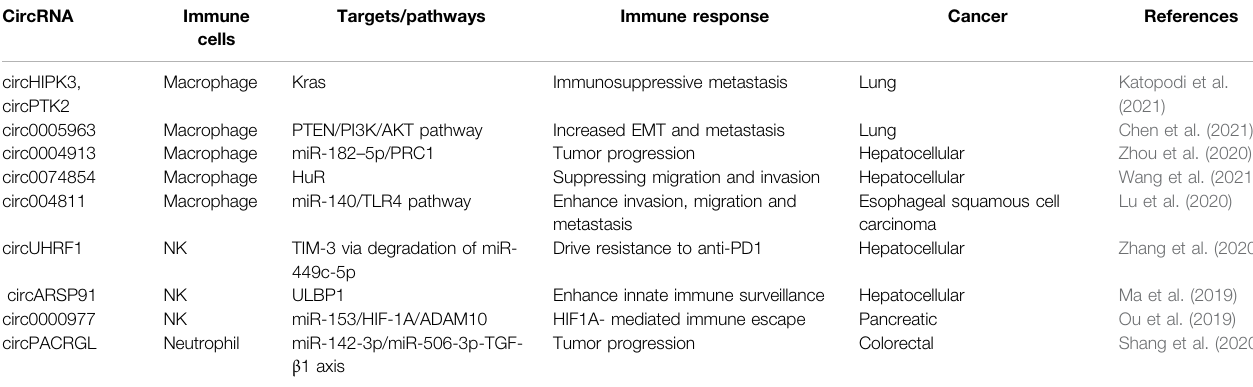
TABLE 1 | circRNAs delivery by tumor cells through exosomes regulate the therapy response of some immune cells in cancer.